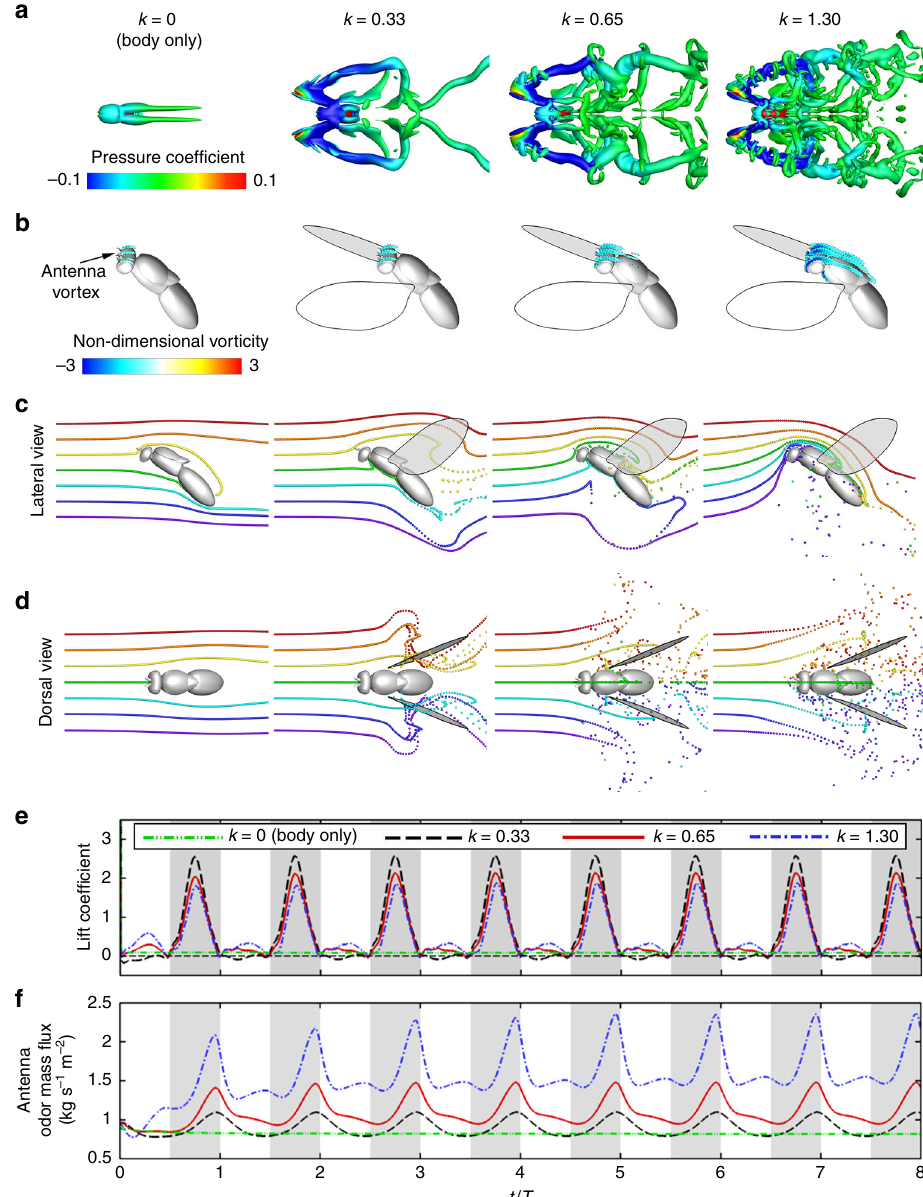
Fig. 2 Fruit fl y in forward fl ight at four different reduced frequencies. a Top view of the wake structures by Q-criterion and color coded with normalized pressure. b Vortex structures over antennae of the fruit fl y and visualized using span-wise vorticity. Blue indicates clockwise vorticity. Both wake structure and antenna vortex intensify at higher reduced frequencies. c , d Odor plume structure visualized using neutral-buoyant particles from lateral ( c ) and dorsal ( d ) releases: snapshot at the time point of peak odor mass fl ux to antennae. The colors of the particle indicate different release locations. As fl apping frequency increases, more odor particles vertically below the body are trapped and fl icked up toward the antennae. However, horizontally, only a narrow stream of particles (green) in the direct path of antenna passes through the antenna region, regardless of fl apping frequency (see also Supplementary Movie 1). e , f Time course of lift coef fi cient ( e ) and odor mass fl ux over the antennae ( f ) under different reduced frequency. The shaded areas represent downstrokes. Lift coef fi cients peak at mid-downstroke phase and decrease with higher reduced frequencies. However, antenna odor mass fl ux peaks during the downstroke to upstroke transition phase and increases with higher reduced same trend. The lift coef fi cient ( C L ) is the total lift force non- distribution contour plot on the wing surface (Fig. 3a; Supple- dimensionalized by wing-tip velocity squared and wing area, mentary Fig. 2) shows that the trailing-edge portions that are which generally re fl ects the ef fi ciency of wing shape and design 27 . important to odor transport as observed previously (upward fl icking) contribute poorly to lift generation. Higher lift coef fi cients can translate into carrying more payload per unit wing area 28 . The data show that increased reduced fre- Intrigued by this observation, we virtually cut off the trailing- quency (from k = 0.65 to k = 1.30) enhances peak odor mass fl ux edge portion of the fruit fl y wing (Fig. 3b) and reran the fl ight over the antennae (59%) but slightly decreases the lift coef fi cient simulation while maintaining all other settings the same. Lift ( − 11%). More importantly, the cycle-average lift coef fi cient production (Fig. 3a – c), vortex formation (Fig. 3d – f), and odor